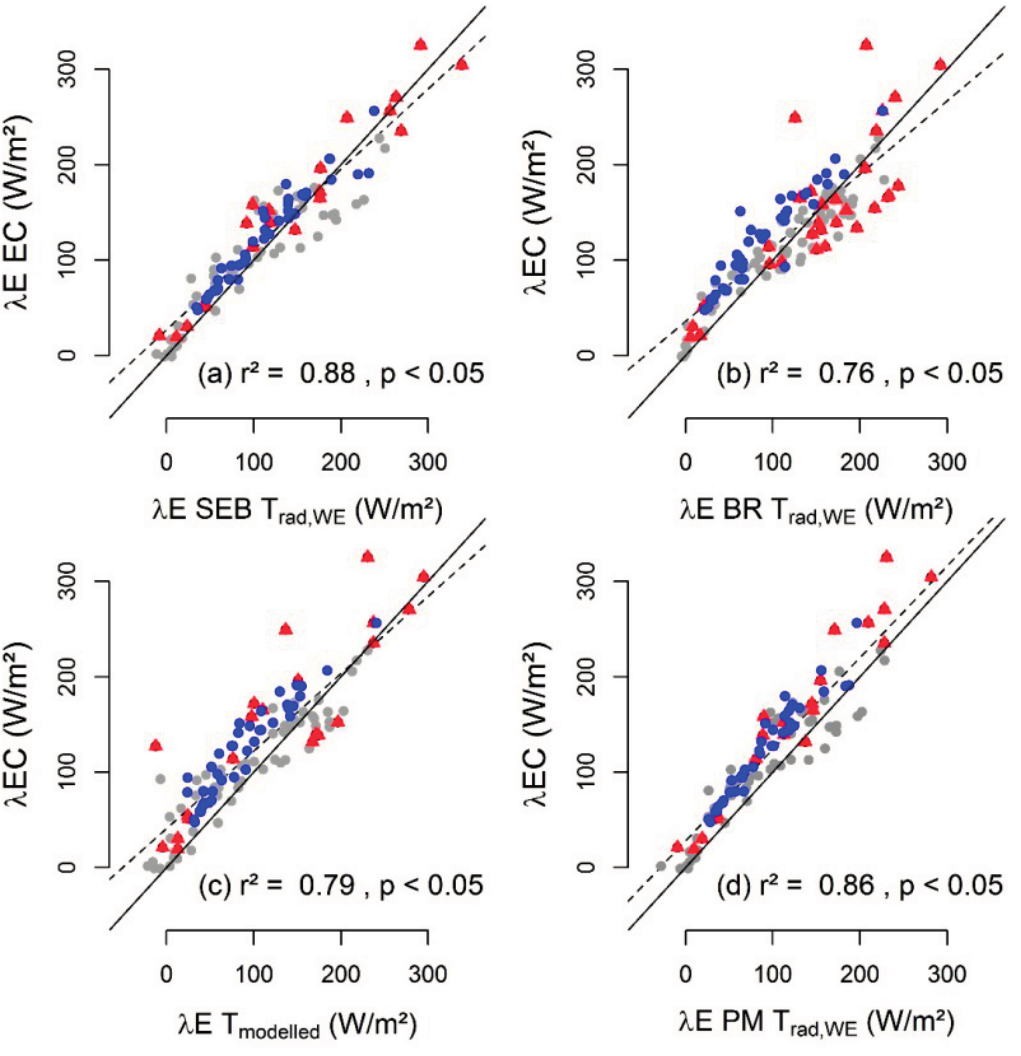
Figure 6. Linear model regression fit between the daytime latent heat flux derived from eddy covariance measurements ( λ E EC) and modeled daytime λ E. Gray dots: cloud fraction < 0.2, red triangles: cloud fraction ≥ 0.2–0.8, blue dots: cloud fraction ≥ 0.8. The solid line represents the line of identity, while the dashed line represents the linear regression line. Input temperatures (T) as for Table 2. Modeling approaches used: ( a ) SEB, ( b ) Bowen ratio, ( c ) T modeled, ( d )